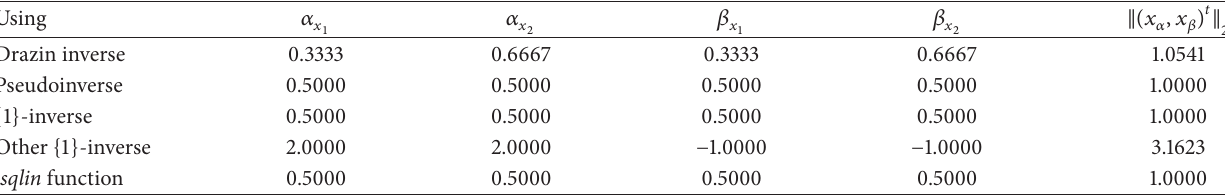
Table 1: Finding the left and right spreads.